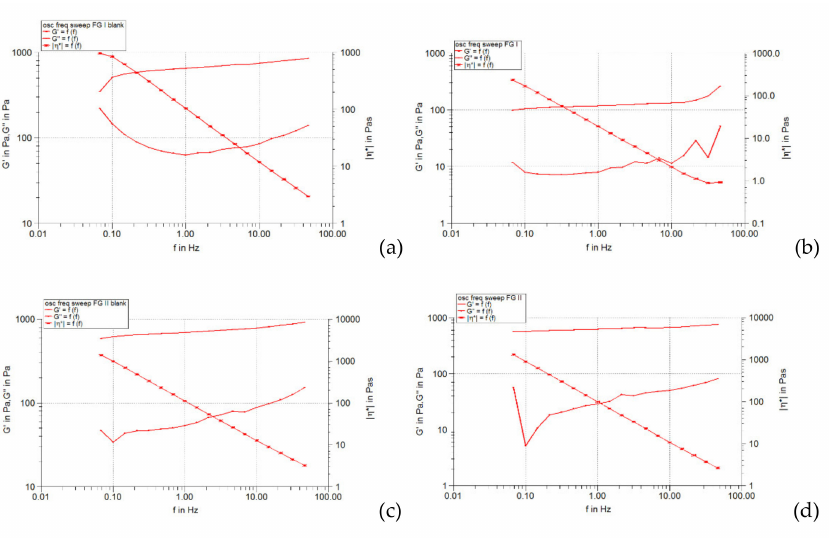
Figure 4. Behavior of G’ and G” viscoelastic modules depending on frequency for Carbopol 940 and glycerol hydrogels, simple or loaded with caffeic acid liposomes: ( a ) FGI blank, ( b ) FGI, ( c ) FGII blank, ( d )